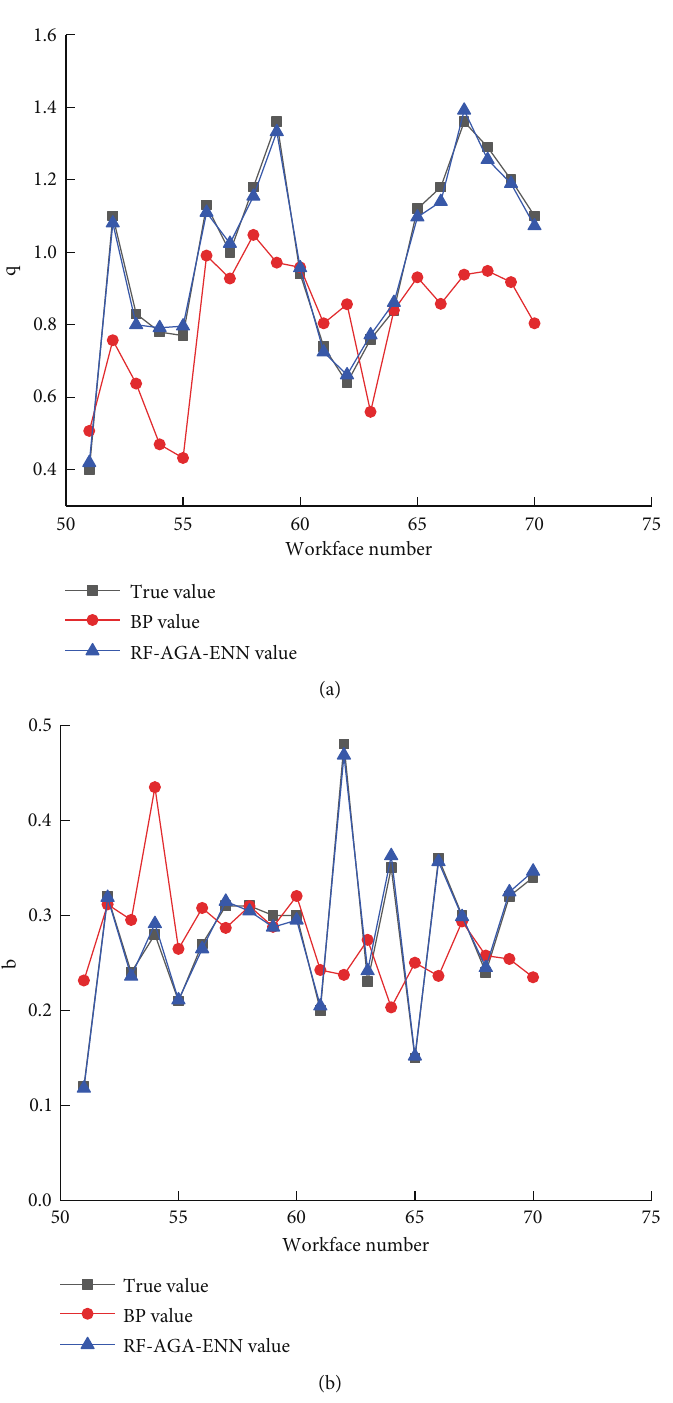
Figure 10: The value of PIM parameters obtained by di ff erent